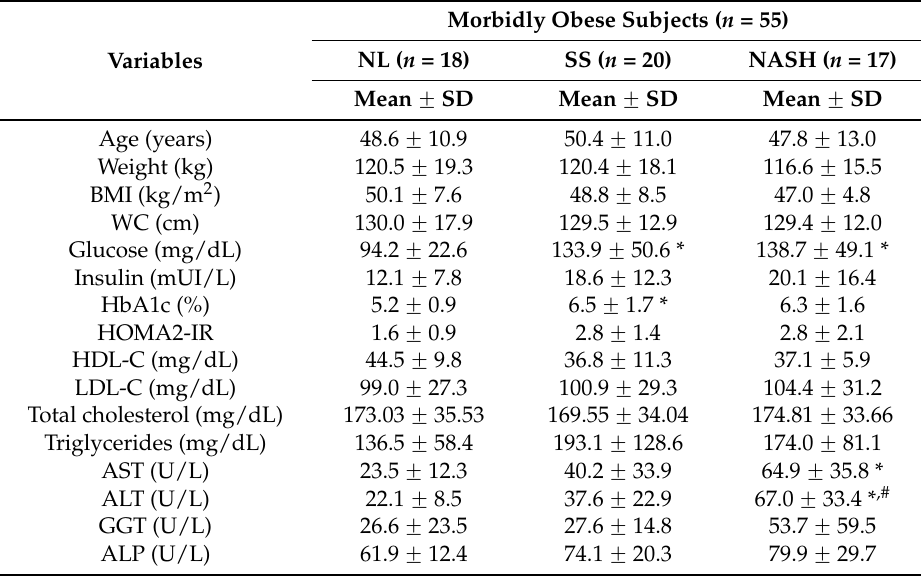
Table 1. General characteristics of the studied cohort classified according to the liver pathology. Morbidly Obese Subjects ( n = 55) NL ( n = Variables